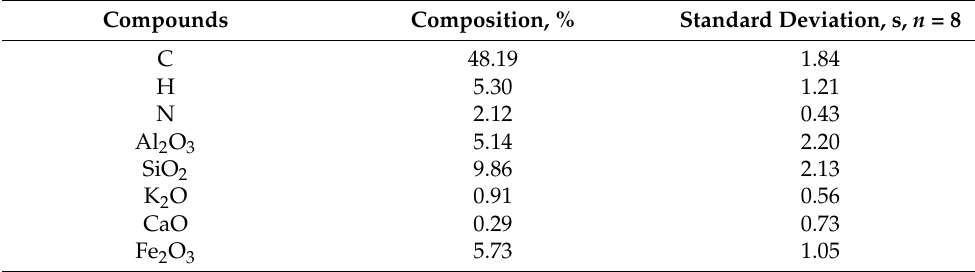
Table 1. Chemical composition of coal mining